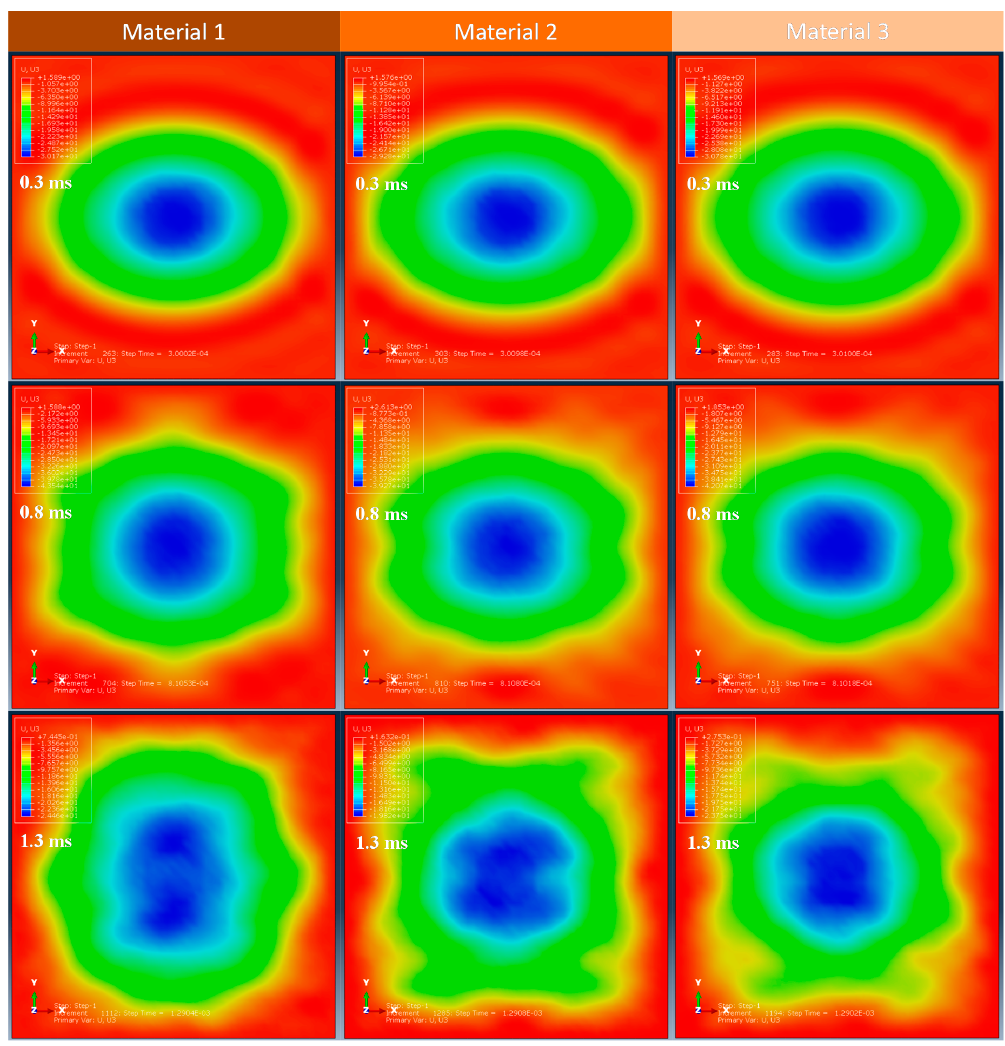
Figure 7. The out-of-plane (U3) displacements of the plates with different material